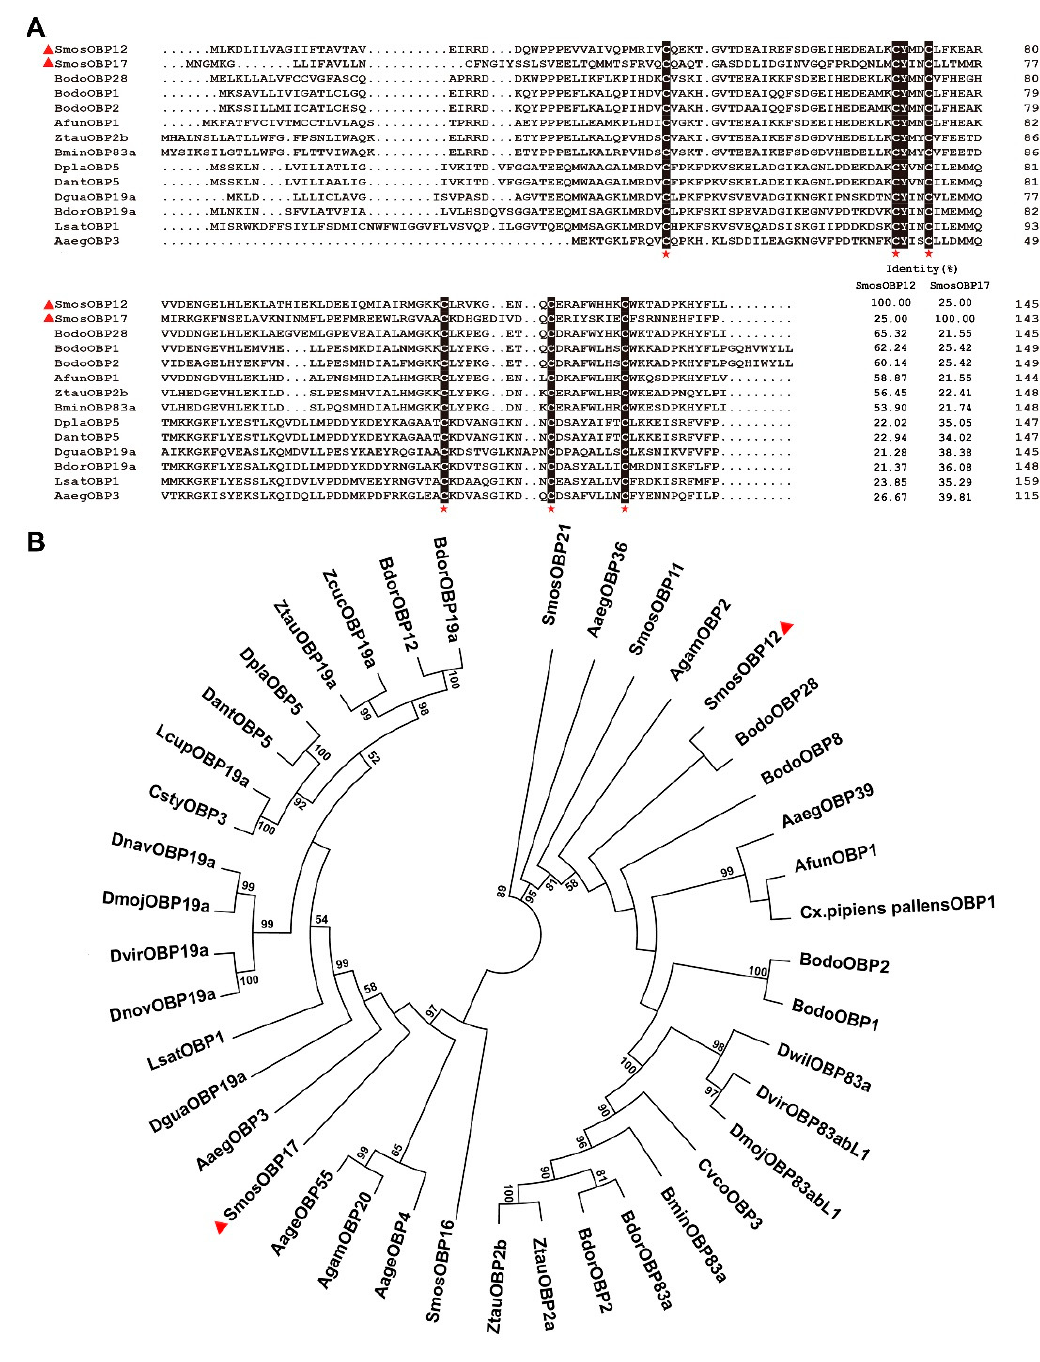
Figure 1. Multiple sequence alignment ( A ) and phylogenetic analysis ( B ) of Sitodiplosis mosellana odorant-binding proteins (SmosOBPs) and dipteran homologs. Six conserved cysteines are marked with red asterisks. SmosOBP12 and SmosOBP17 are indicated by red triangles. The phylogenetic tree was built using the neighbor-joining method with 1000 bootstrap replications and presented with a cuto ff value of 50. Gene names and GenBank accession numbers of 41 OBPs are as follows: S. mosellana (SmosOBP12, MG585343; SmosOBP17, MG585345; SmosOBP11, MG585344; SmosOBP16,